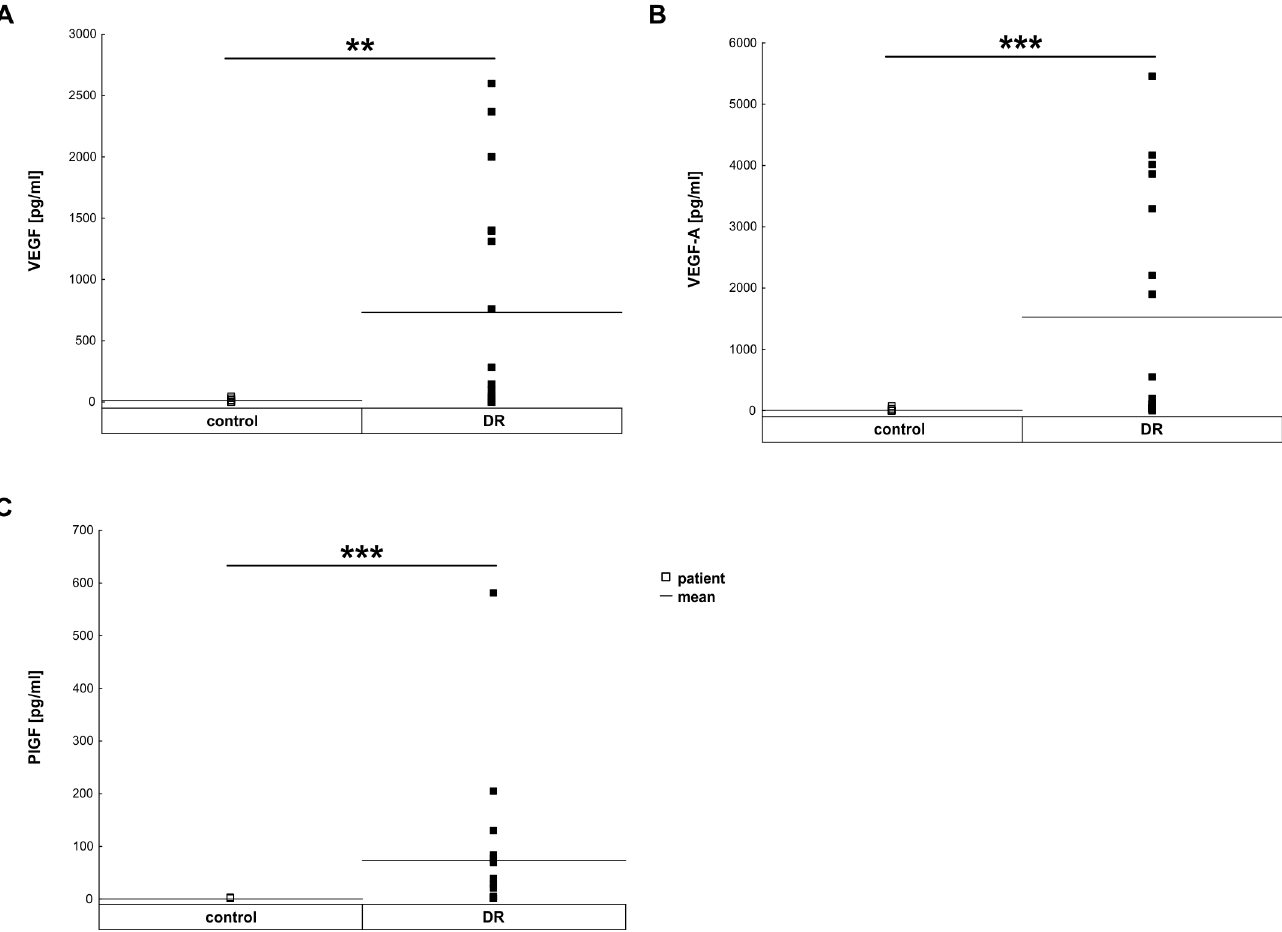
Fig 3. Up-regulation of different angiogenic factors in vitreous samples. A. Total VEGF was significantly up-regulated in vitreous samples of DR patients (p = 0.002). B. VEGF-A was also significantly up-regulated in DR patients (p < 0.001). C. Additionally, PGF was upregulated in DR samples compared to controls (p < 0.001). Each symbol depicts an individual patient. The horizontal bar indicates the mean cytokine concentration per group. (cid:3)(cid:3) : p < 0.01, (cid:3)(cid:3)(cid:3) : p < 0.001.